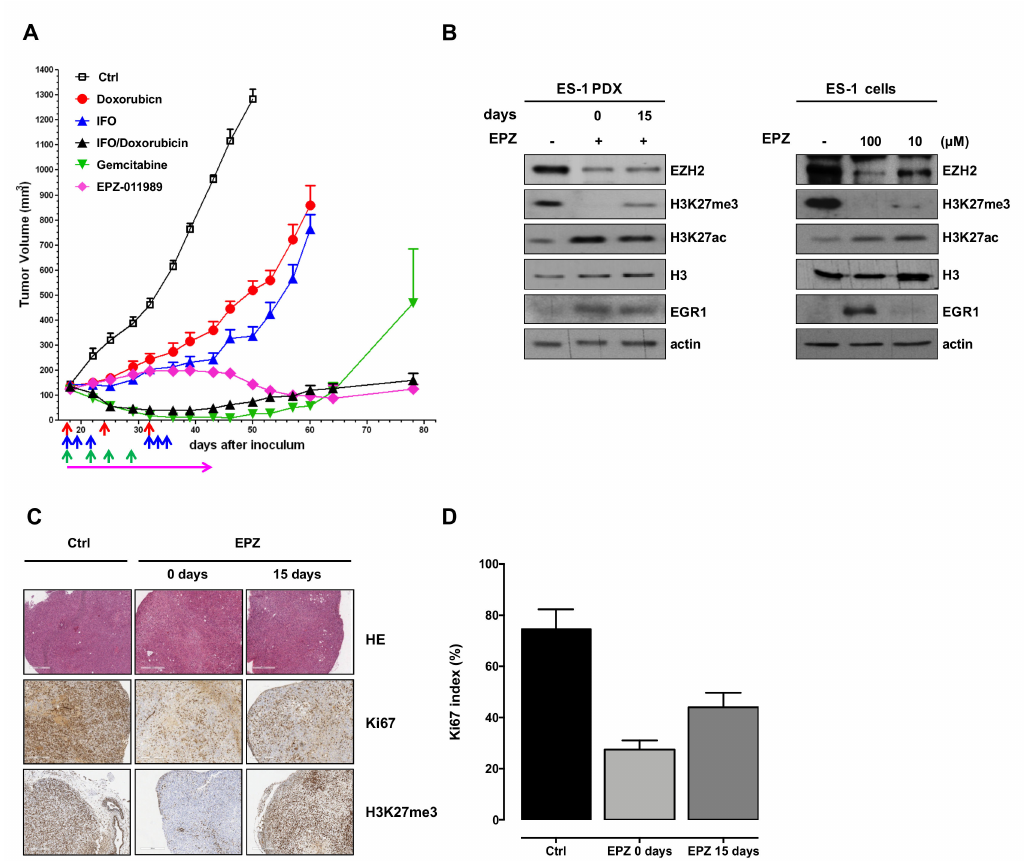
Figure 2. Antitumor activity and biochemical e ff ects induced by EPZ-011989 in ES-1 PDX and derived cell line. ( A ) Antitumor activity of doxorubicin, ifosfamide (IFO), singly administered and in combination, gemcitabine, and EPZ-011989 (EPZ) in ES-1 PDX. Eight mice per experimental group were used. Growth curves report the average tumor volume ( ± SE) in control and drug-treated animal groups. The arrows in the figure indicate when the drugs were administered. ( B ) Western blot analysis of trimethylated and acetylated lysine 27 of histone H3 (H3K27me3 and H3K27ac, respectively), total histone H3, EZH2, and EGR1 levels in ES-1 tumors removed from untreated ( − ) and EPZ-011989-treated mice at di ff erent intervals from the end of treatment (left panel) and in ES-1 untreated and EPZ-011989-treated cells with di ff erent concentrations of EPZ-011989 for 96 h (right panel). Cropped images of selected proteins are shown. A representative Western blot of three independent experiments is shown. ( C ) Pathologic evaluation of ES-1 tumors obtained from untreated (Ctrl) and EPZ-011989-treated mice at di ff erent intervals from the end of treatment. Ki67 and H3K27me3 immunostaining of the same tumors are also presented. (scale bars = 500 µ m for HE, 400 µ m for Ki67 and H3K27me3). ( D ) Quantification of Ki67 index in untreated and EPZ-011989-treated tumors. Data are reported as mean ± SD of six di ff erent